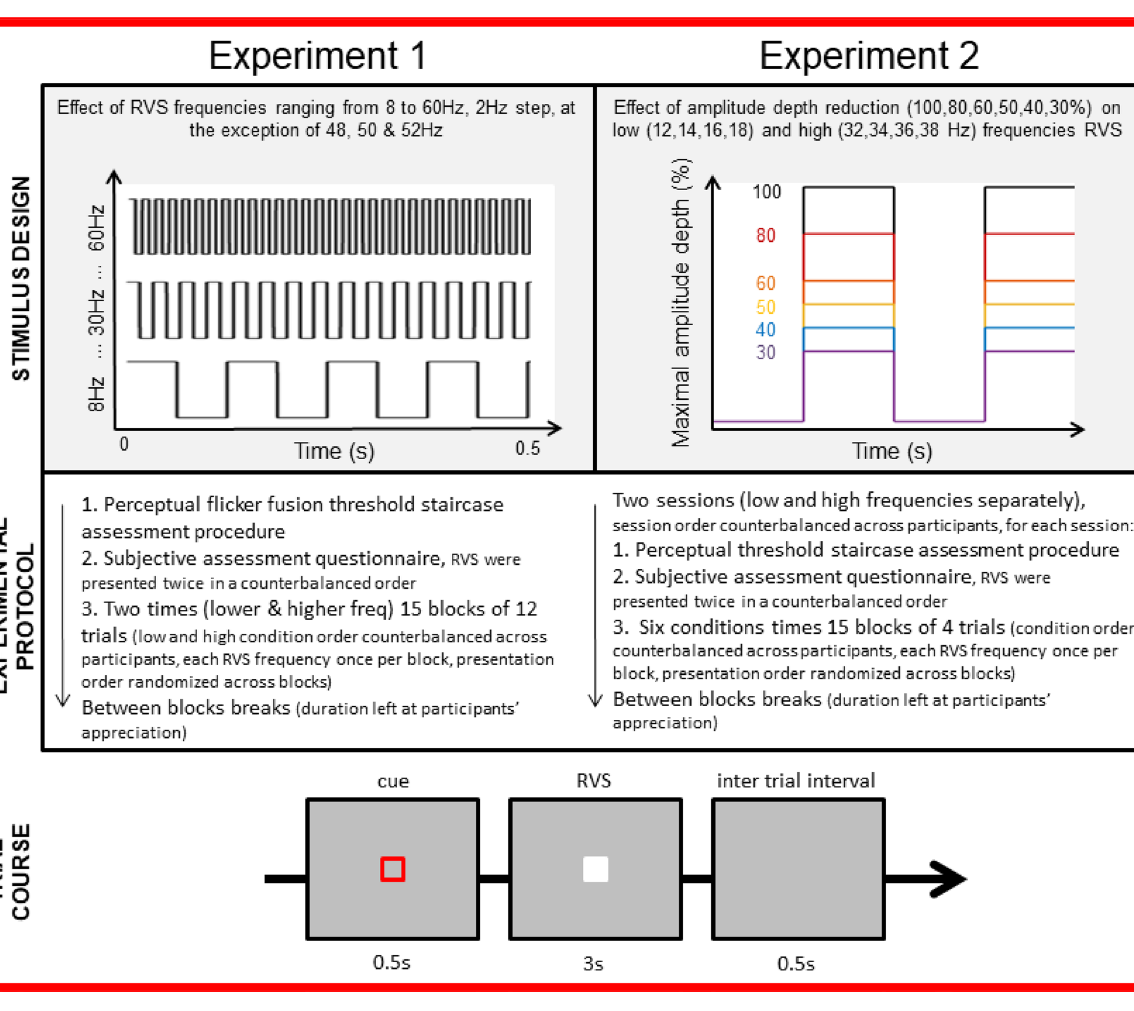
Figure 7. Experiments 1 and 2 : illustration of the repeated visual stimuli (RVS) design for each experiment (manipulating stimuli frequency and amplitude depth), experimental protocols descriptions and a diagram presenting trial course parameters used across both